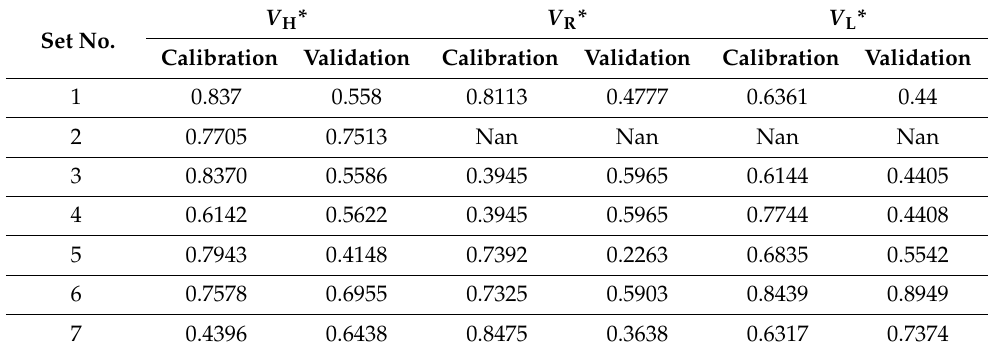
Table 5. Correlations of MARS performance in the calibration and validation stages for 3D scour rates. V H * V R * V L Set No.